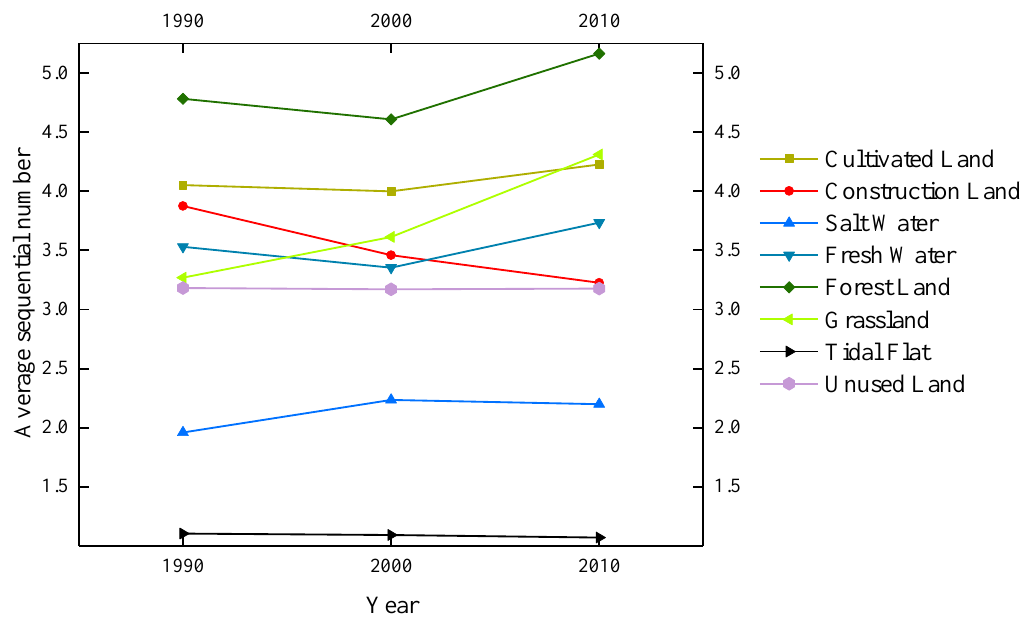
Figure 6. The annual average sequential number of land use along the sea–land direction in the period of 1990 – 2010.